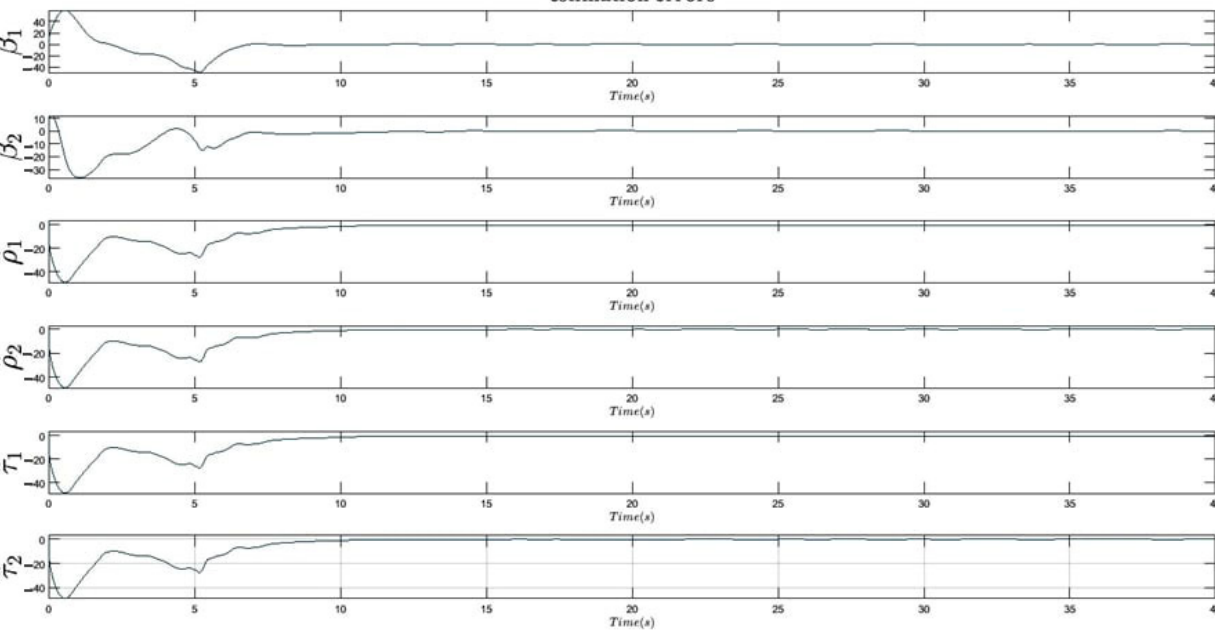
Figure 6. Estimation error of the system parameters.